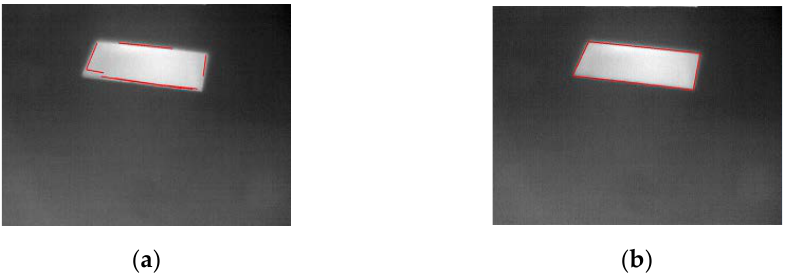
Figure 6. Edge extraction of thermal images. ( a ) Traditional method; ( b ) proposed method.